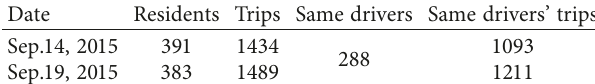
Figure 3: Analysis process in the study. Table 2: Sampling quantity of the drivers and